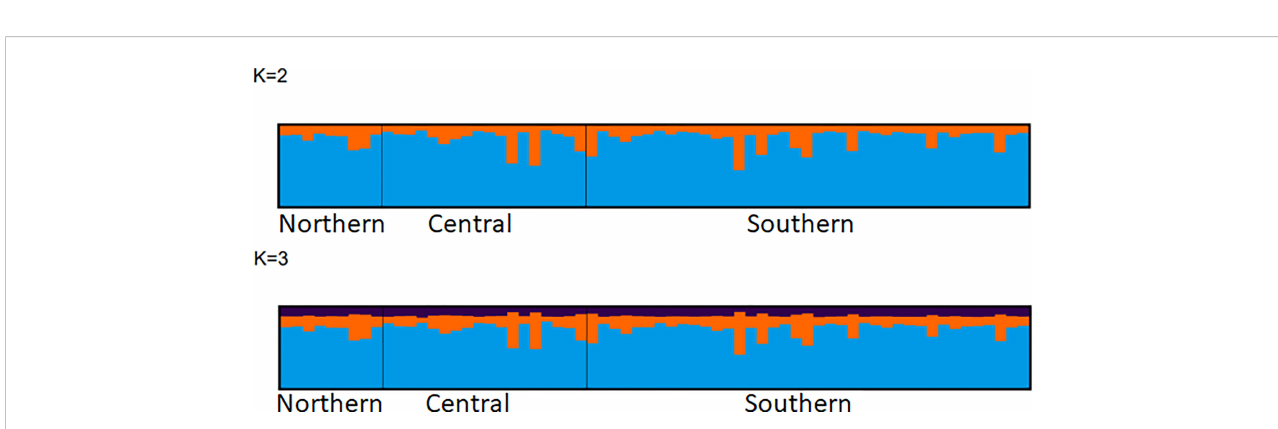
FIGURE 5 Structure barplot obtained from 1,304 SNPs loci in 66 individuals. Posterior probabilities of individual assignment are shown for two K values (K=2, and K=3) for comparison.